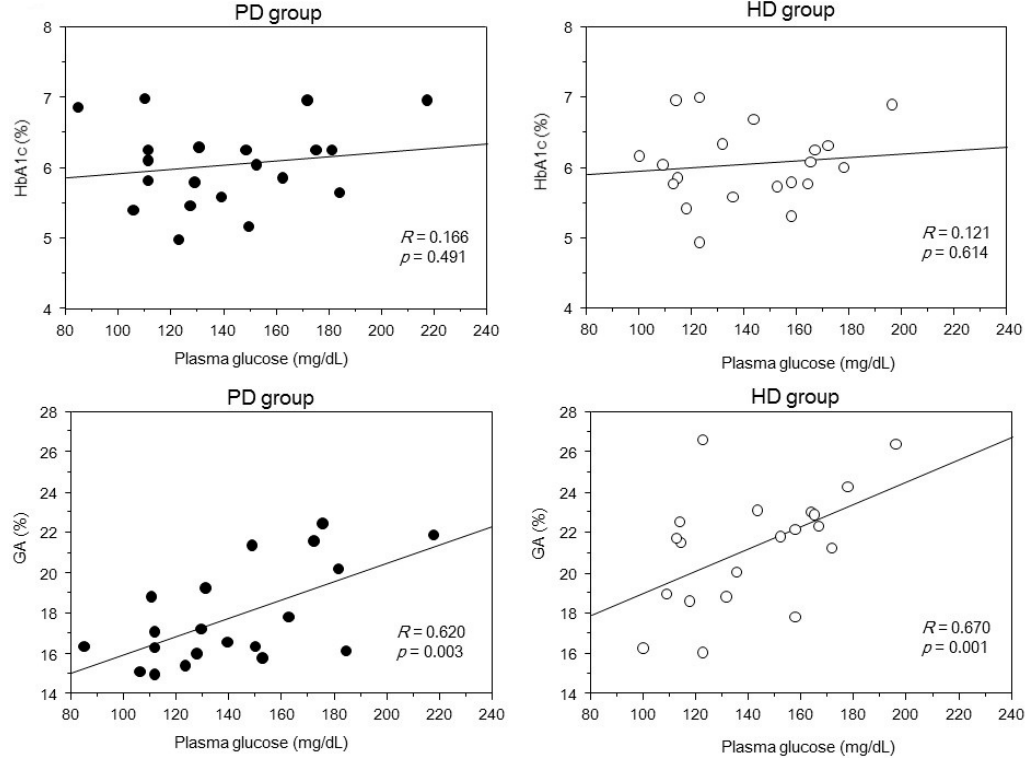
Figure 2. Association of mean plasma glucose level with mean HbA1c level and mean GA level in diabetic patients on dialysis. HD, hemodialysis; PD, peritoneal dialysis.